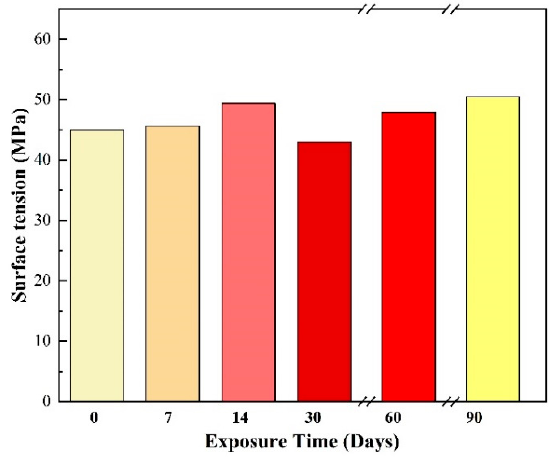
Figure 4. Surface tension of printed materials exposed to natural sunlight for three months.